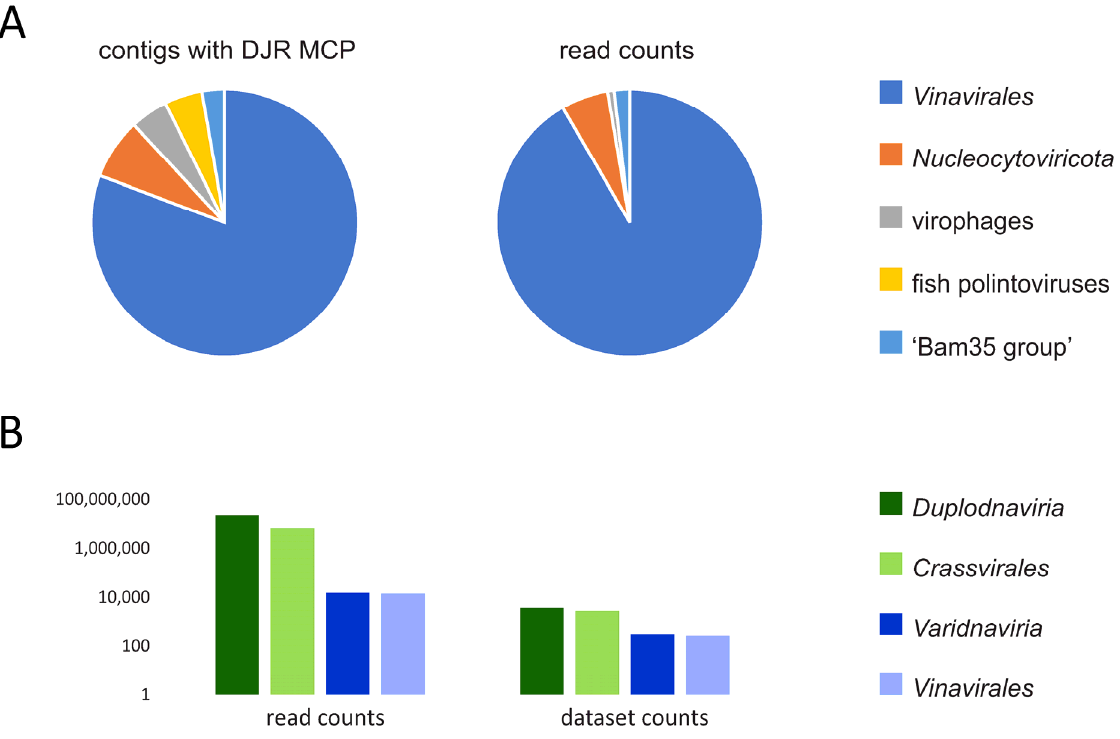
Figure 1. Abundance of DJR MCP in human gut metagenomes. ( A ) Number of contigs assigned to different groups of varidnaviruses ( left ) and number of reads mapped to DJR MCPs of each of these groups ( right ). ( B ) Comparison of the number of the counts of reads and datasets (metagenomes) for HK97 MCP ( Duplodnaviria ) and DJR MCP ( Varidnaviria ). The abundance of members of Duplodnaviria and Varidnaviria in the gut